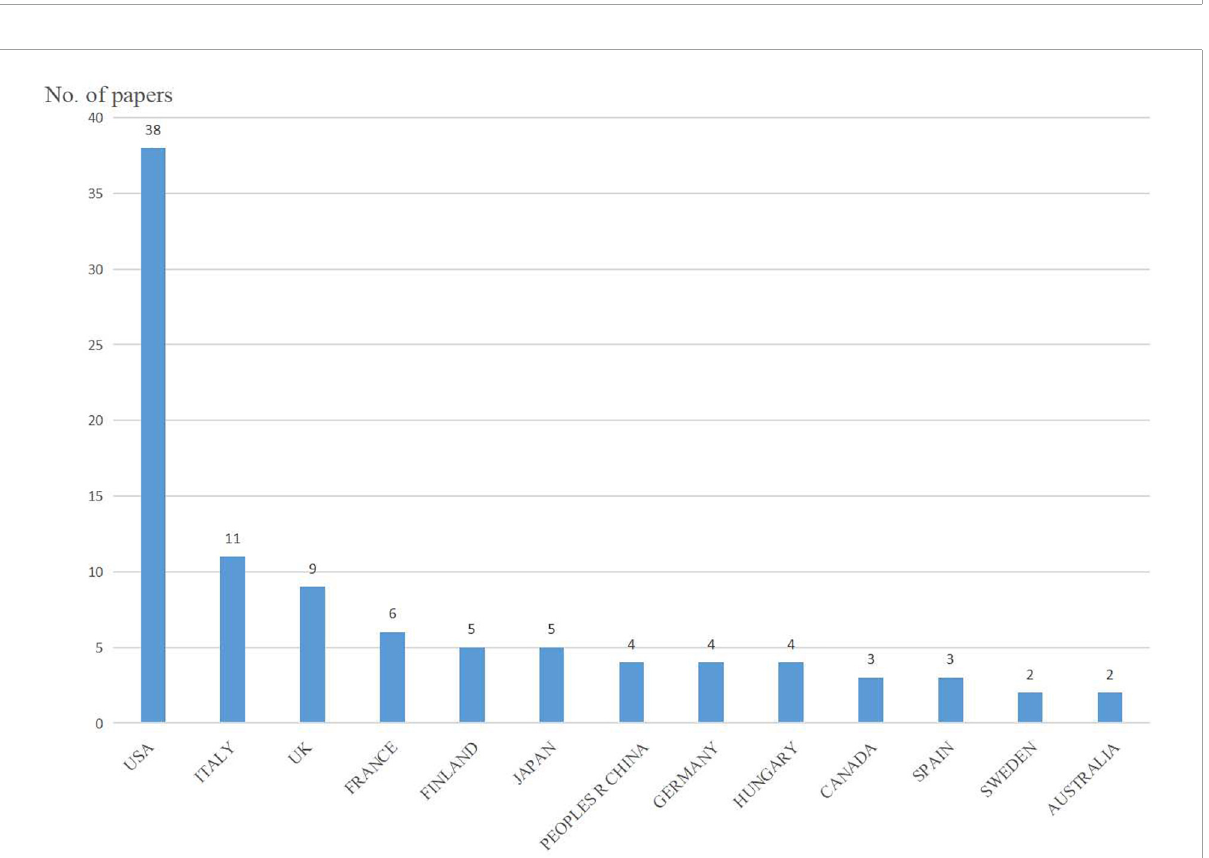
FIGURE3 Countries among the top 100 most-cited